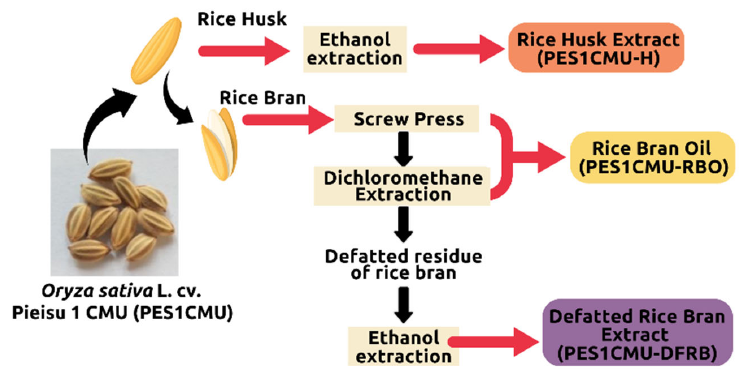
Figure 6. An overview of the extraction process of Oryza sativa L. cv. Pieisu 1